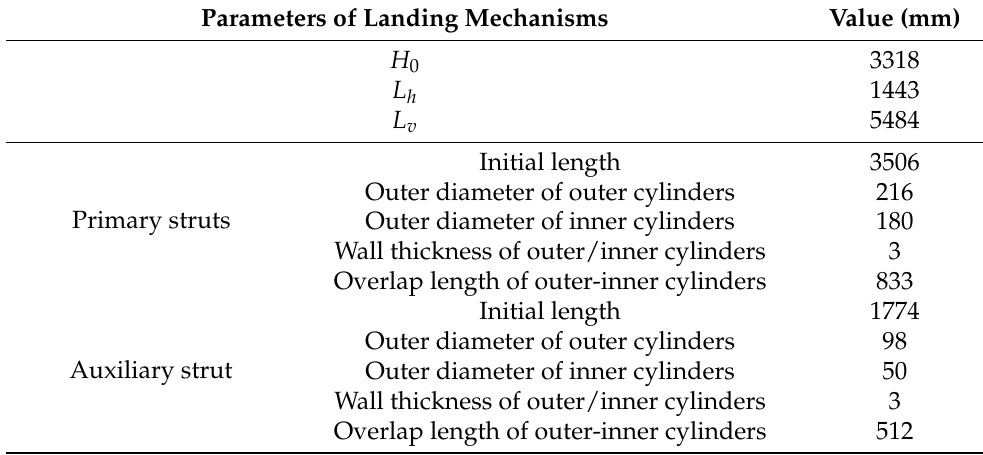
Table 2. Parameters of landing